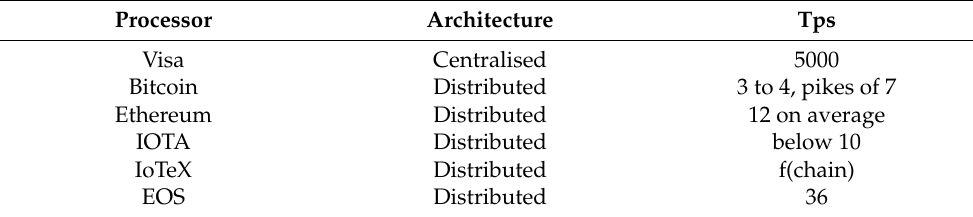
Table 4. Typical transactions per second (tps).